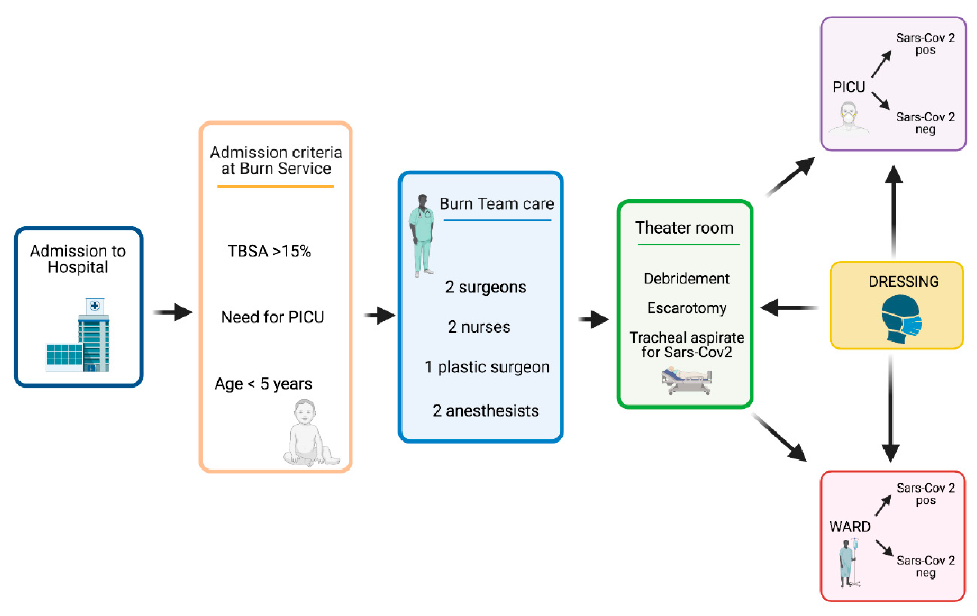
Figure 1. Patient care process. Created with BioRender.com (https://biorender.com/) (access on 7 May